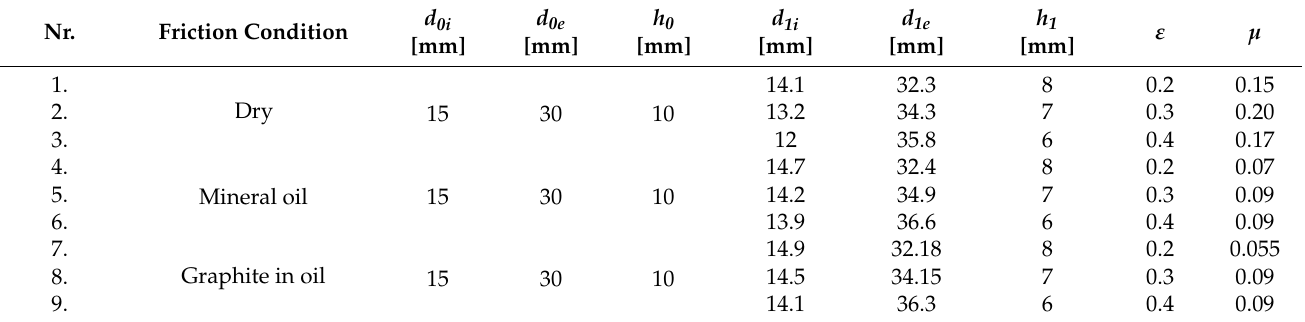
Table 2. Experimental results of friction coefficient determinate by the Coulomb friction